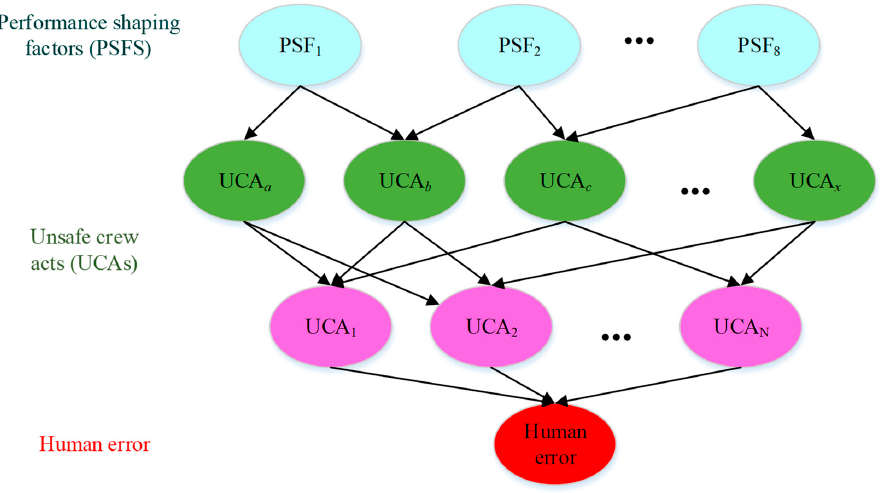
Figure 4. BN-based causal model.